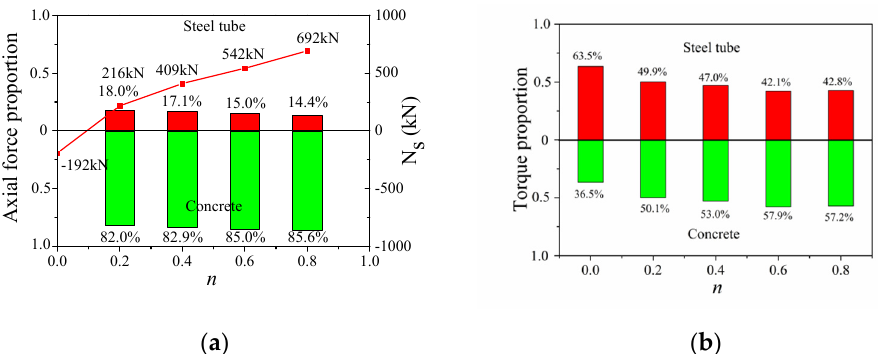
Figure 9. Load-bearing proportion of steel tube and concrete: ( a ) Axial force proportion and N s ; ( b ) torque proportion.